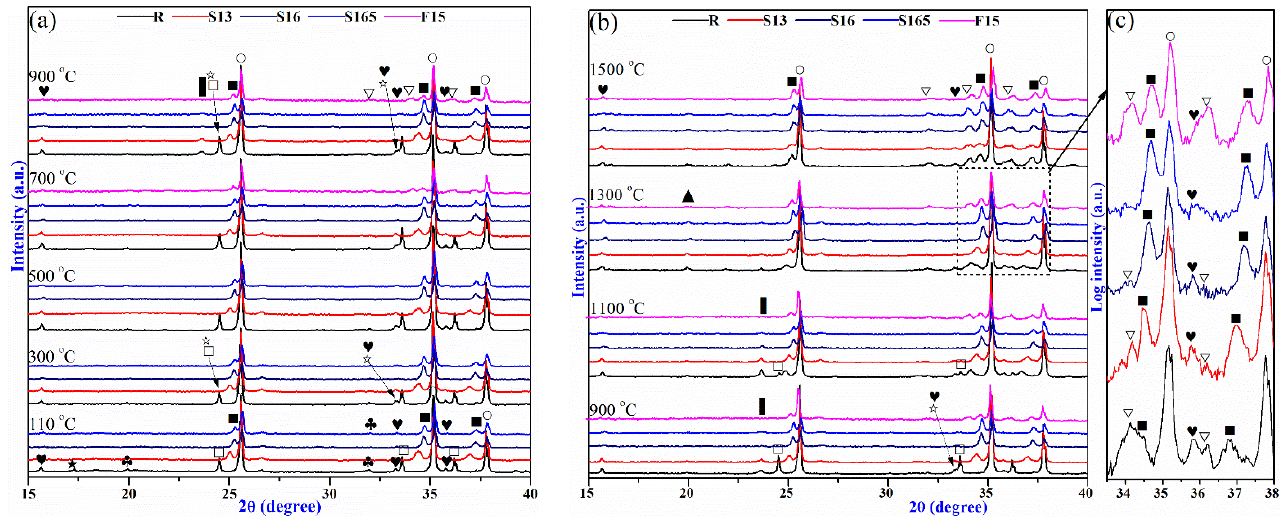
Figure 3. XRD patterns of Al 2 O 3 -CaO-Cr 2 O 3 castables, ( a ) 110–900 °C, ( b ) 900–1500 o C, ( c ) 1300 °C. ○ —Corundum (Al 2 O 3 ), ■ —(Al 1-x ,Cr x ) 2 O 3 solid solution, □ —Eskolaite (Cr 2 O 3 ), ☆ —CaCrO 4 , ▍ —Hauyne (Ca 4 Al 6 CrO 16 ), ▽ —CA 6 (CaAl 12 O 19 ), ♥ — NaAl 11 O 17 , ♣ —C 3 AH 6 (Ca 3 Al 2 (OH) 12 ).